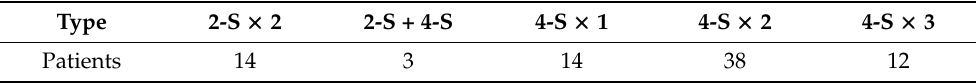
Table 1. Lengthening types by segments (S: